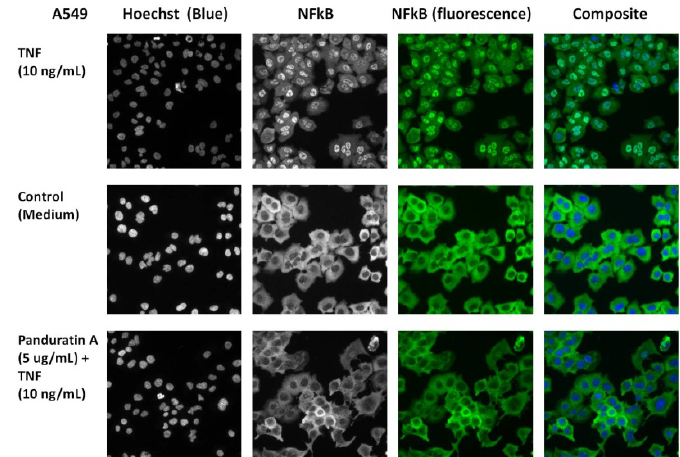
Figure 11. Stained A549 cells were treated with panduration A (5 µg/mL) for 2 hours and then stimulated for 30 minutes with 10 ng/mL TNF- α (NF- κ B